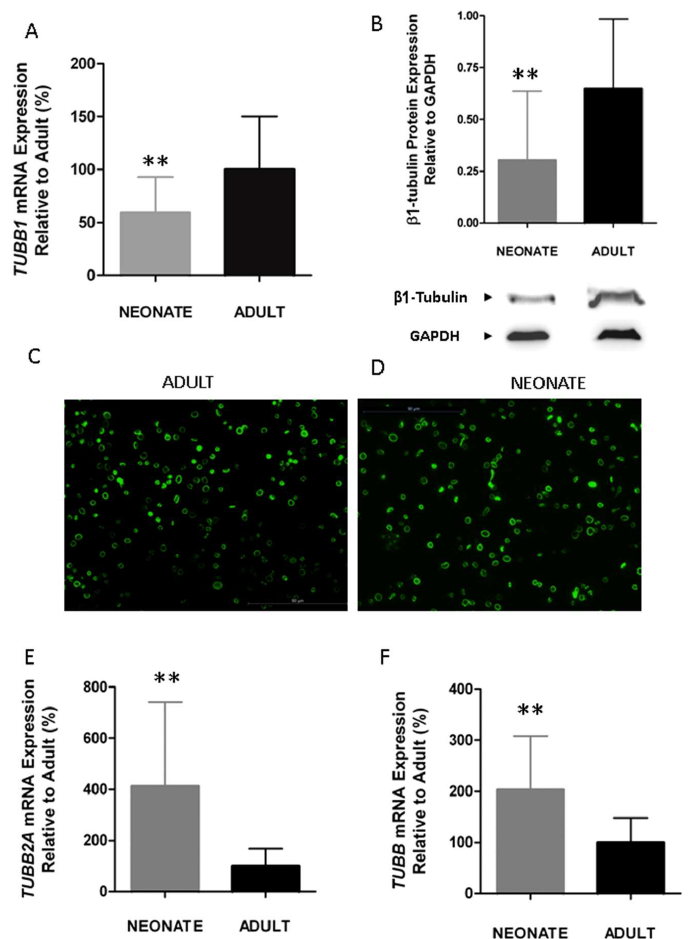
Figure 4. Neonatal platelets display a reduced expression of β 1-tubulin but an overexpression of other isoforms ( TUBB2A and TUBB ), allowing a normal marginal band. ( A ) TUBB1 mRNA level measured by quantitative real time qRT-PCR and normalized with respect to ACTB ( n = 21 / group). ( B ) Quantification of β 1-tubulin protein levels by immunoblotting. Western blot pictures shown are representative images cropped from two gels performed at the same time and under the same conditions ( n = 15 samples / group). Quantification was performed by densitometric analysis using the ImageJ program, and was normalized to β -Actin. ( C , D ) Microscopy of adult and neonatal platelet marginal bands using α -tubulin immunofluorescence in adhered platelets on poly- l -lysine. ( E , F ) Quantification of TUBB2A and TUBB mRNA levels by qRT-PCR ( n ≥ 10 samples per group). ** p < 0.01. Taken from [63] with